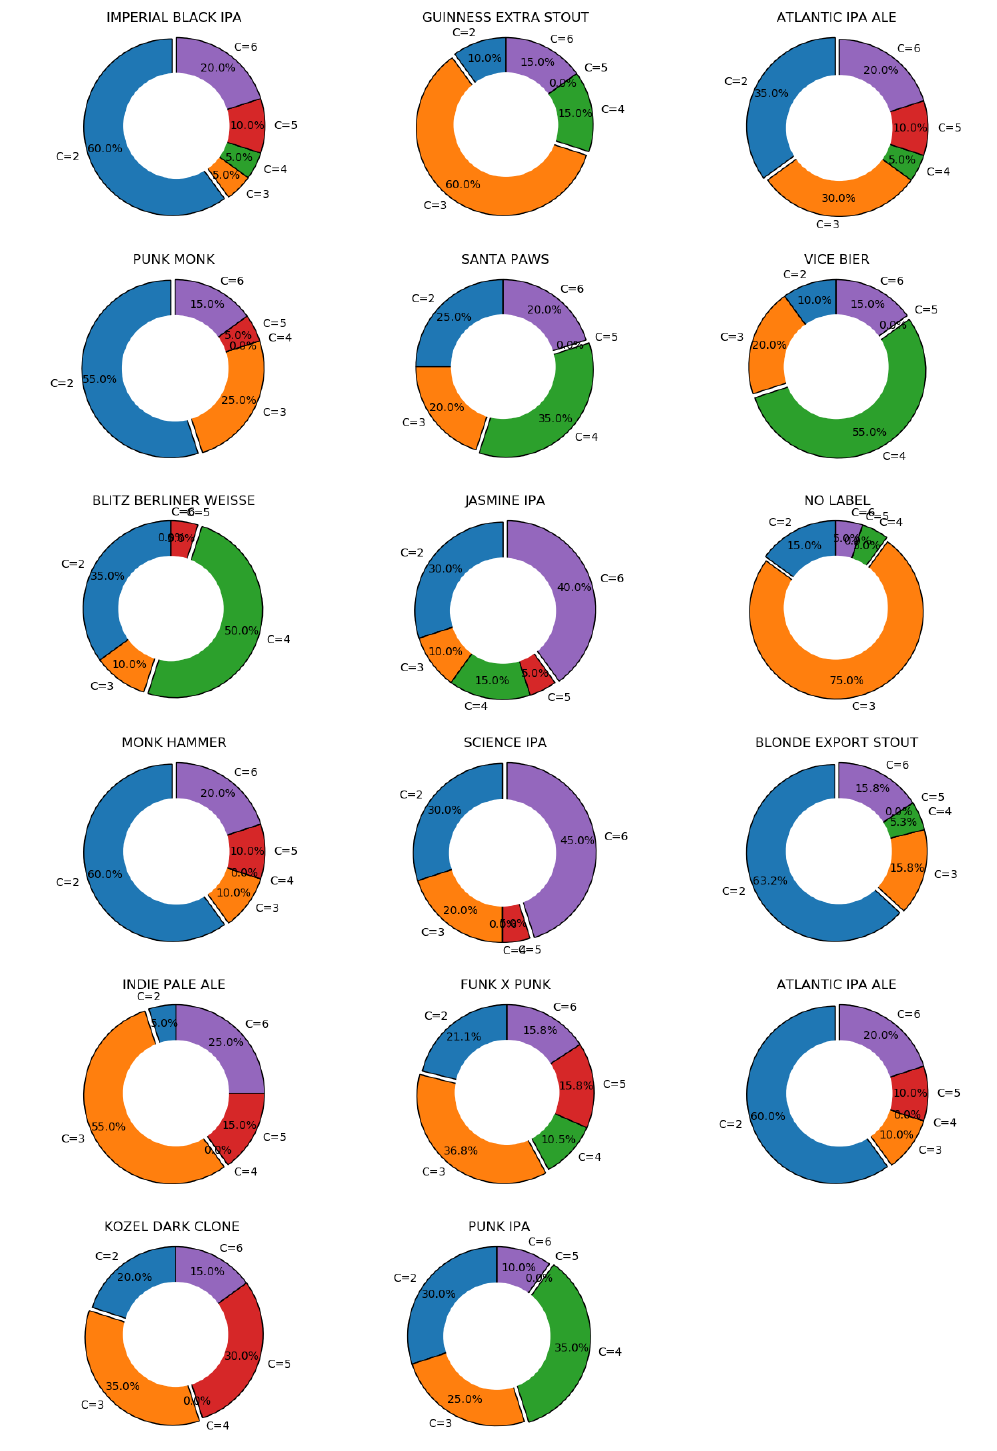
Figure A3. Strength of the possible number of clusters in each product, where C = { 2,...,6 } represents the number of clusters. The strength of each proposed number of clusters is determined by taking into account 20 clustering